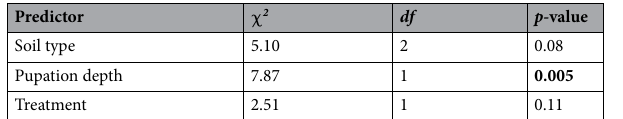
Table 4. Hatched flies—generalised linear mixed effect model (family = binomial, link = logit, random factors: “Box/Pupae number”, “Percent pupated”, “Mean Temperature”) output quantifying the effect of pupation depth, soil type and the treatment (with wasp/without wasp) on the hatching rate of the fly D. suzukii. Significant values are in bold.